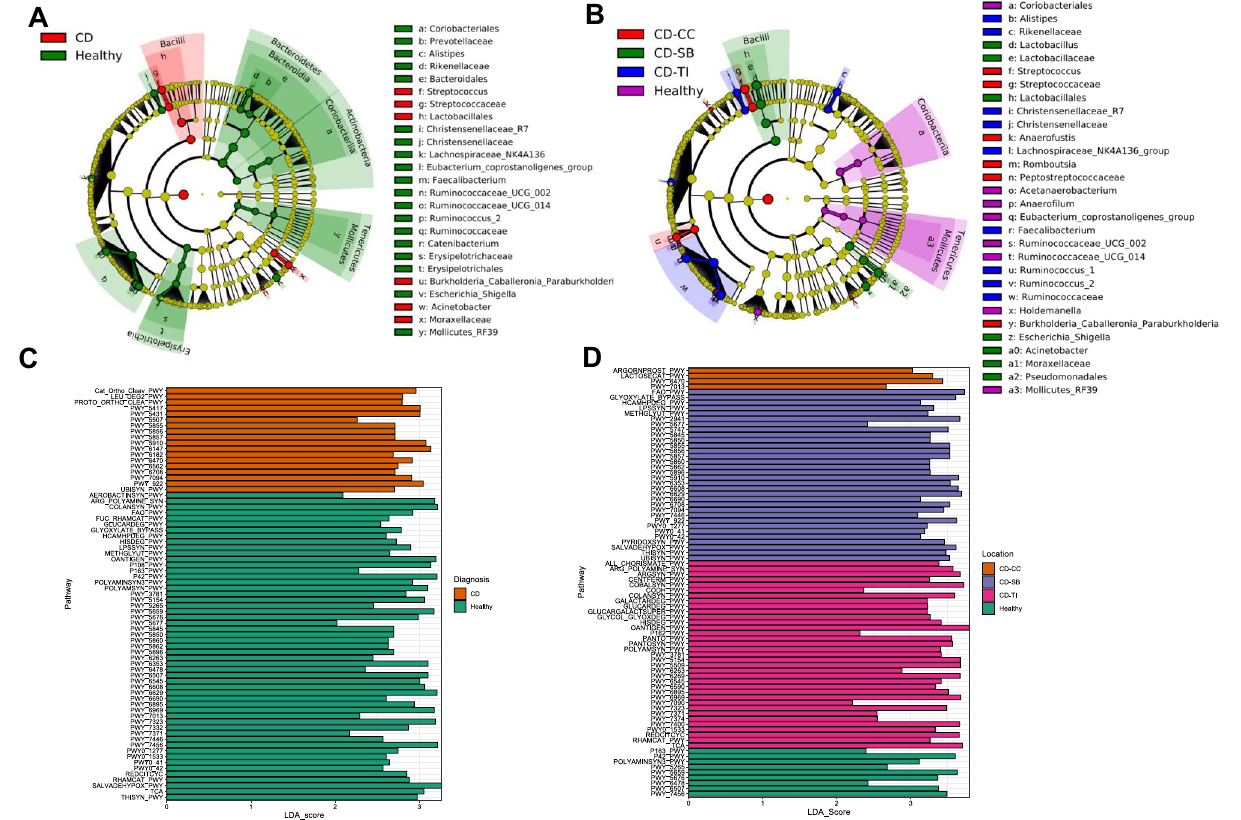
Figure 2. ( A ) Cladogram demonstrating taxa which are enriched in each patient group when comparing Healthy Controls and CD patients. ( B ) Cladogram demonstrating taxa which are enriched in each patient group when comparing Healthy Controls and CD patients when accounting for disease location. ( C ) Changes in metabolic pathways between Healthy Controls and CD Patients. ( D ) Changes in metabolic pathways between Healthy Controls and CD patients when accounting for disease